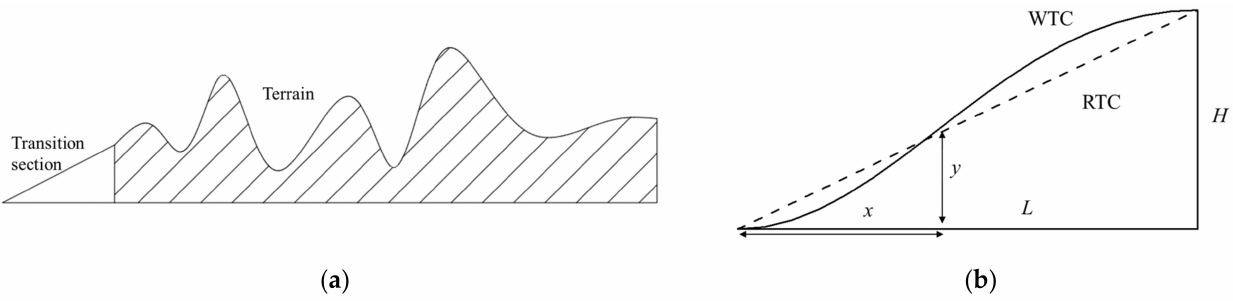
Figure 2. Transition section: ( a ) sketch of transition section; ( b ) sketch of transition